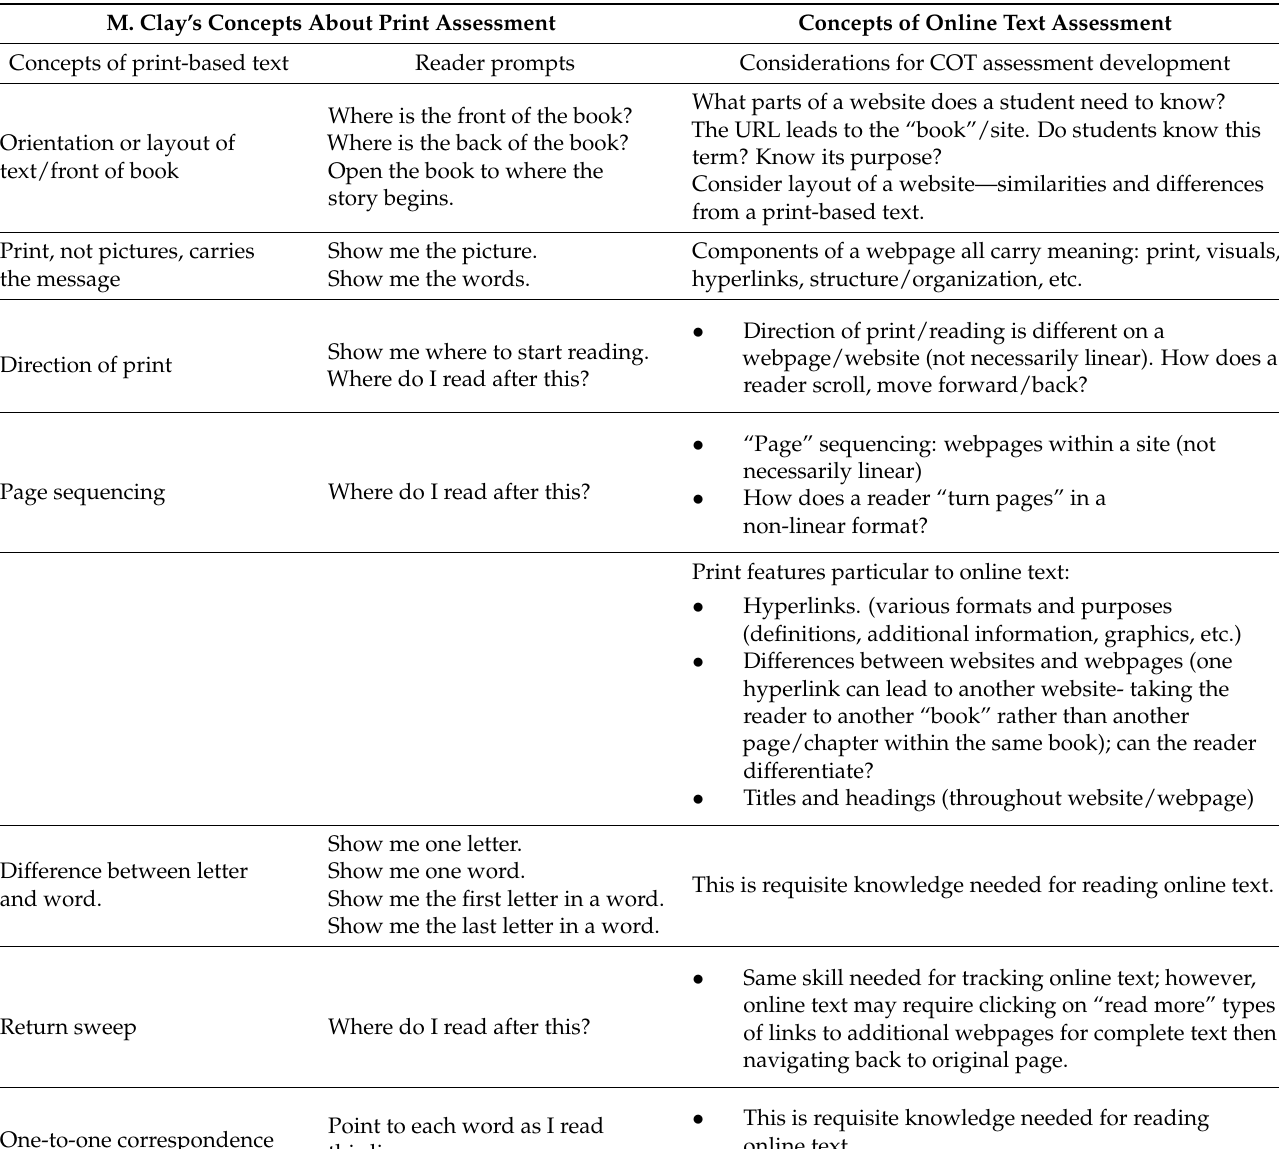
Table 1. Considerations for concepts of online text assessment based on concepts about print